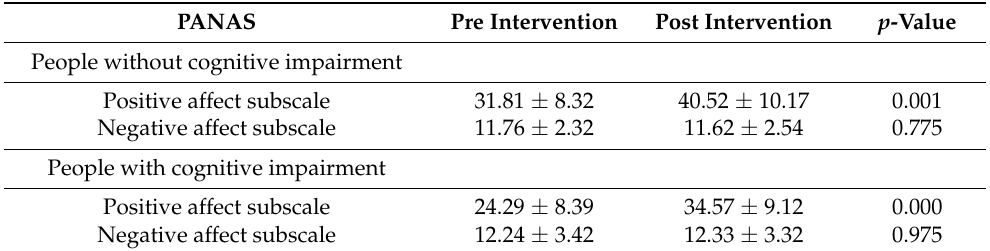
Table 3. PANAS of positive and negative affect before and at the end of the intervention for both groups of subjects. Bold values indicate statistical significance ( p < 0.05).